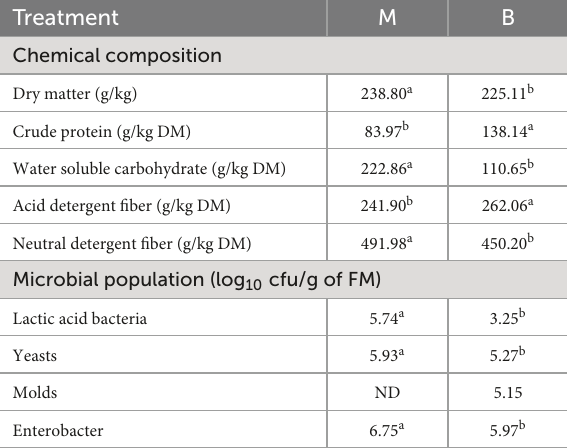
TABLE 1 Chemical composition and microbial population before ensiling.